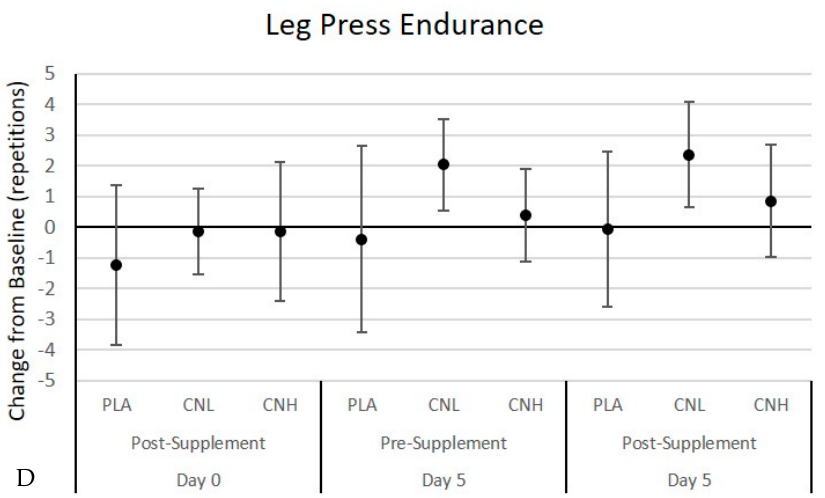
Figure 5. Bench press one repetition maximum (1 RM) ( A ), bench press endurance ( B ), leg press 1 RM ( C ) and leg press endurance ( D ) changes from baseline values for the placebo (PLA), low dose creatine nitrate (CNL), and high dose creatine nitrate (CNH) treatments. Data are mean changes (95% CI). Confidence intervals not crossing zero are statistically significant ( p < 0.05). a represents p < 0.05 difference from PLA. b represents p < 0.05 difference from CNL. † represents p > 0.05 to p < 0.05 effect.